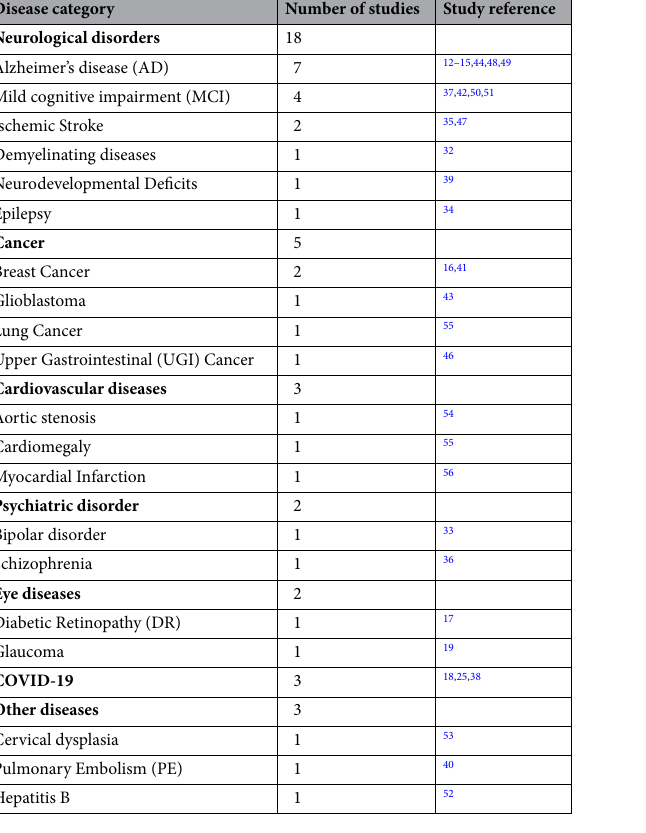
Table 3. Disease distribution covered by the 34